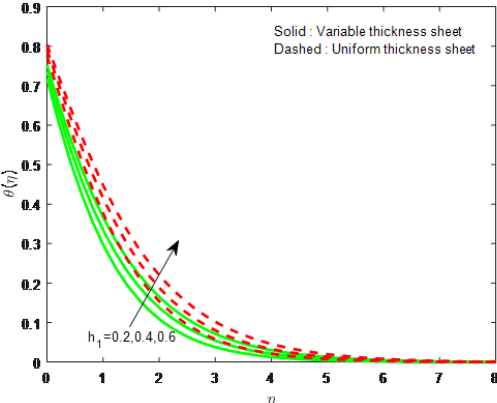
Fig. 12: Influence of β on temperature field